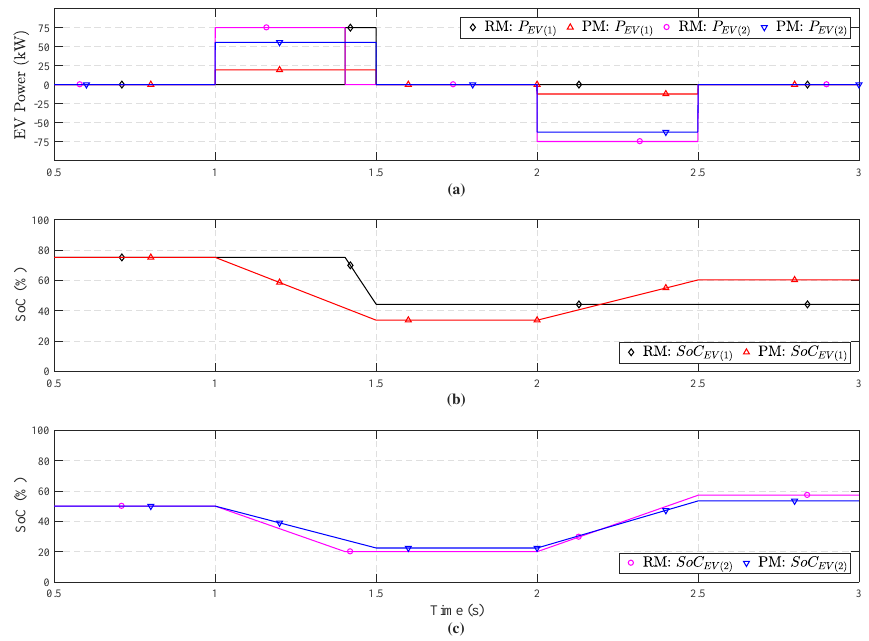
Figure 15. ( a ) Discharging and charging power of the two EVs under the reference method (RM) and the proposed method (PM). ( b ) EV 1 SoC comparison RM vs. PM. ( c ) EV 2 SoC comparison RM vs. PM.